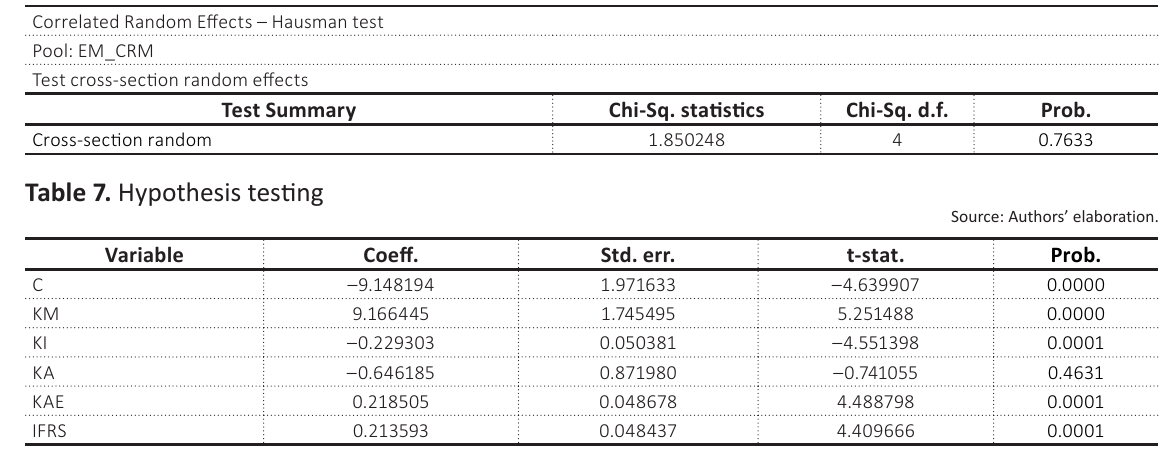
Table 6. Hausman test results of EM_RM as a dependent variable